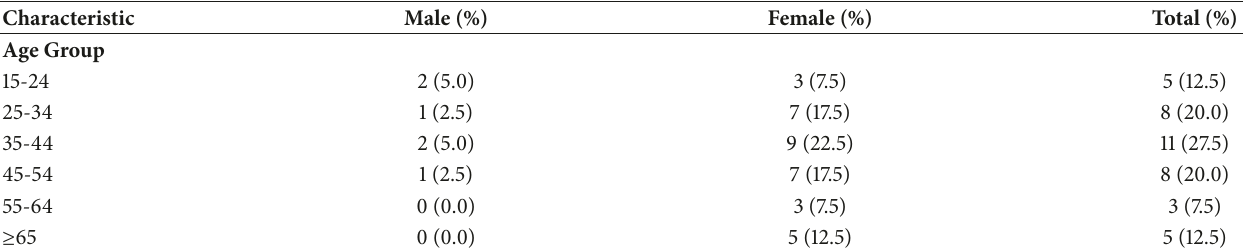
Table 1: Age group of participants according to gender of participants.